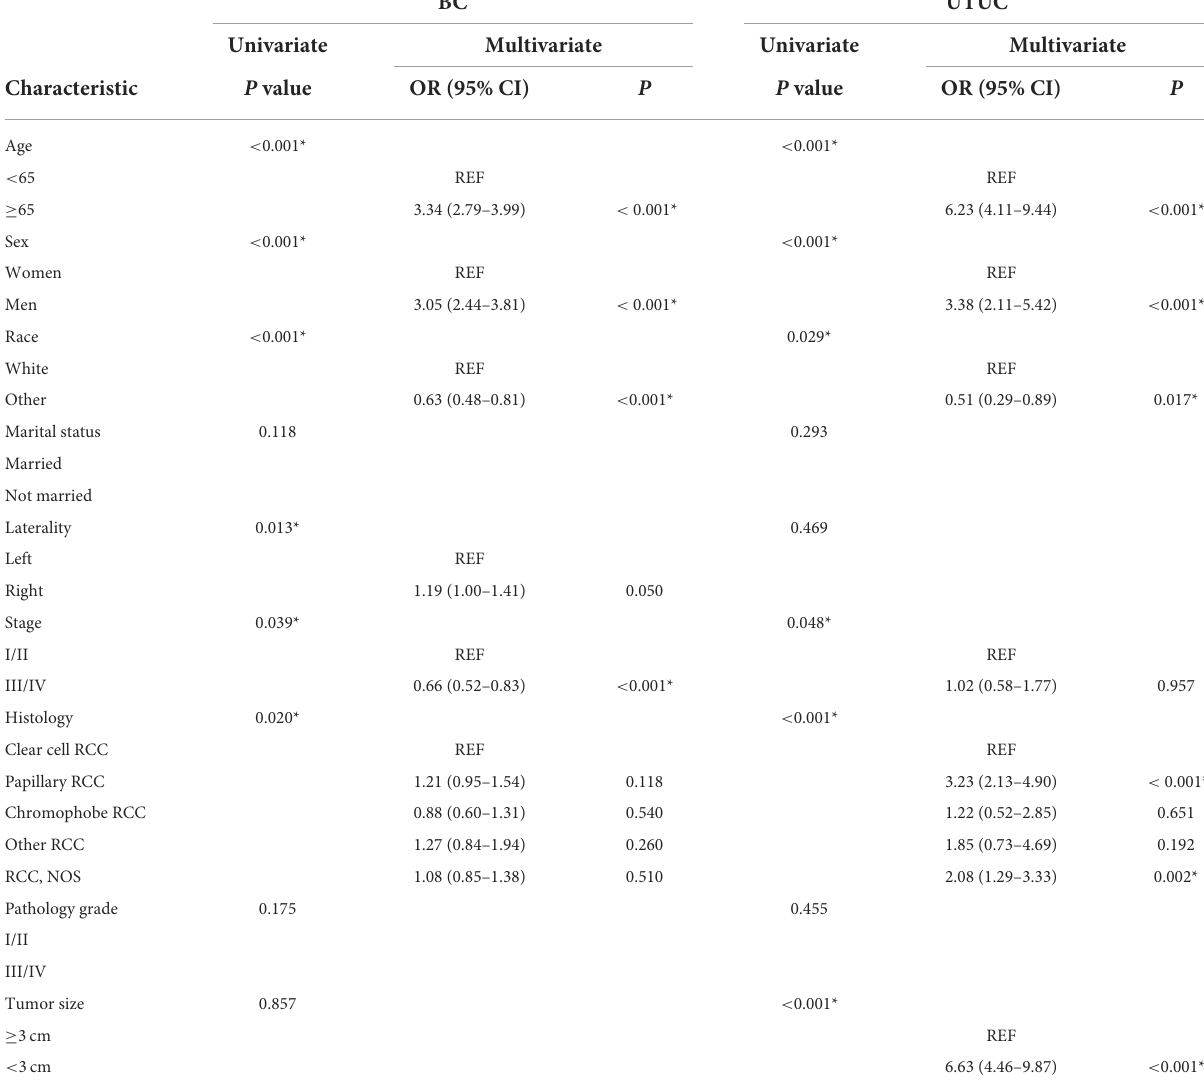
TABLE 2 Logistic regression analysis of risk factors for synchronous RCC and UC a . BC UTUC Univariate Multivariate Univariate